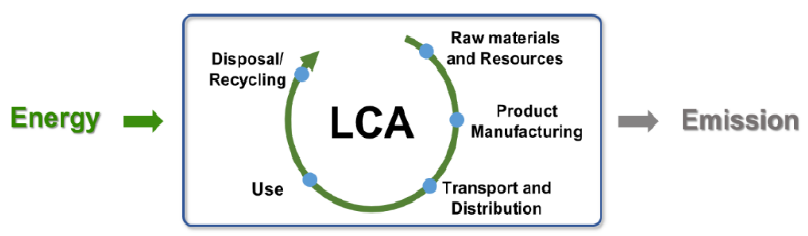
Figure 1. General concepts of the LCA procedure [27].